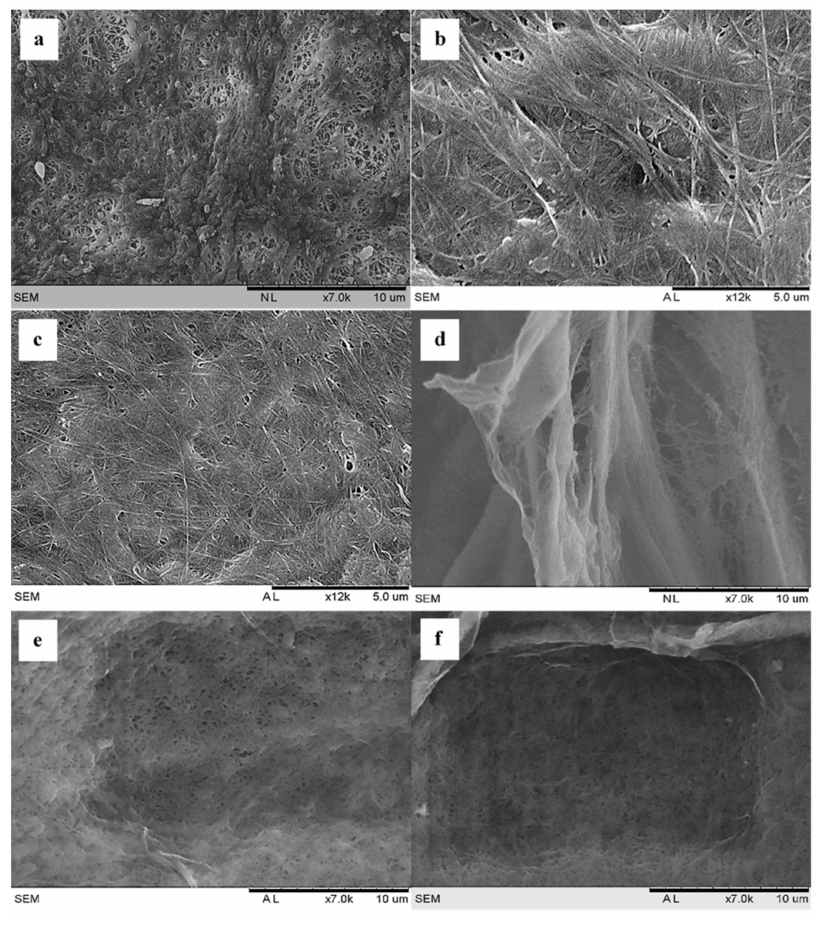
Figure 1. Scanning electron microscope (SEM) images for ( a ) bacterial cellulose (BC), ( b ) MBC0.03,